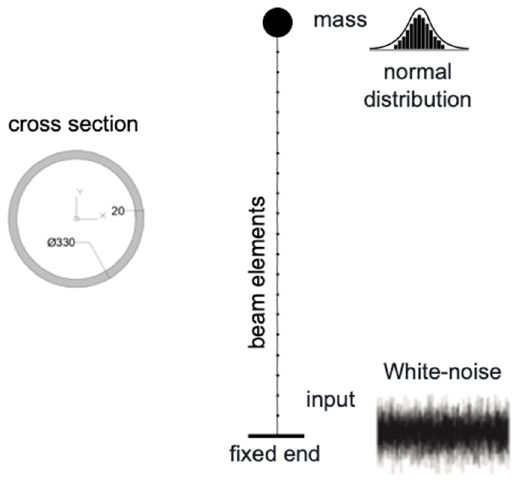
Figure 3. Scheme of the FE model.